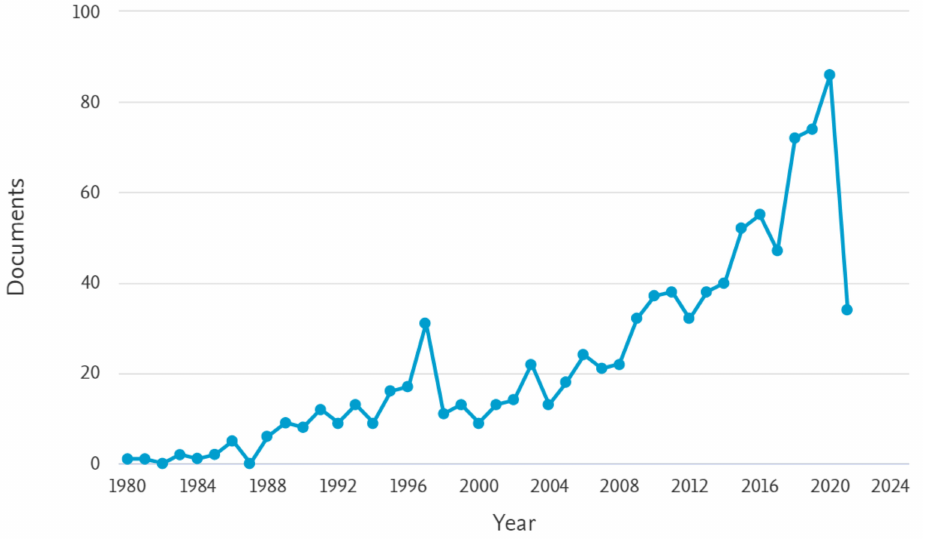
Figure 2. Documents by year (source: